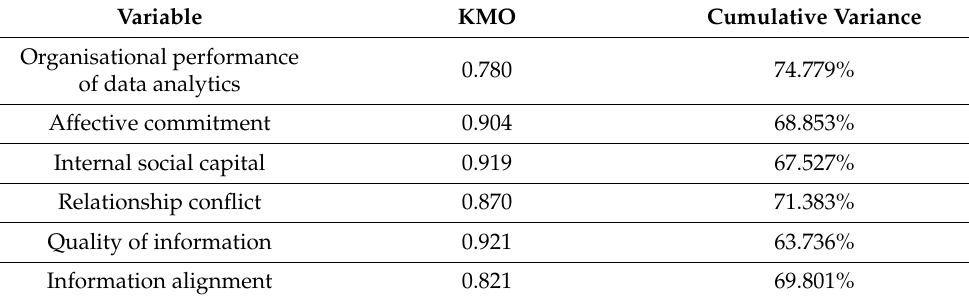
Table 3. EFA results.